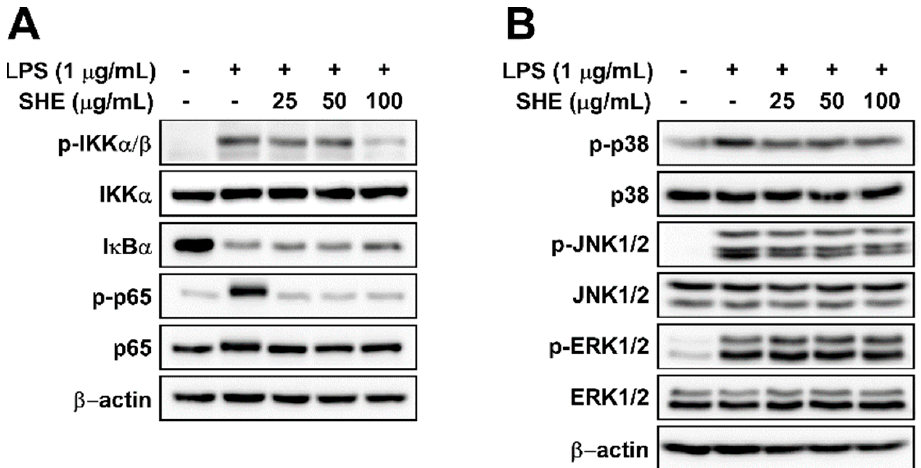
Figure 2. Effects of Soroseris hirsuta extract (SHE) on lipopolysaccharide (LPS)-induced nuclear factor kappa-light-chain-enhancer of activated B cells (NF- κ B) and mitogen-activated protein kinase (MAPK) signaling pathways in RAW 264.7 cells. ( A ) SHE inhibited the LPS-induced phosphorylation of the inhibitor of nuclear factor κ B kinase (IKK) and p65. SHE protected dose-dependent degradation of I κ B by LPS treatment. Cells were treated with SHE 1 h before exposure to LPS (1 µ g/mL) for 30 min. ( B ) SHE inhibited the LPS-induced phosphorylation of p38 and c-JUN N-terminal kinase (JNK) 1/2, but did not affect the phosphorylation of extracellular signal-regulated kinase 1/2 in RAW 264.7 cells. Cells were treated with SHE 1 h before exposure to LPS for 30 min. The phosphorylation and expression of each protein were detected by Western blotting using specific antibodies.